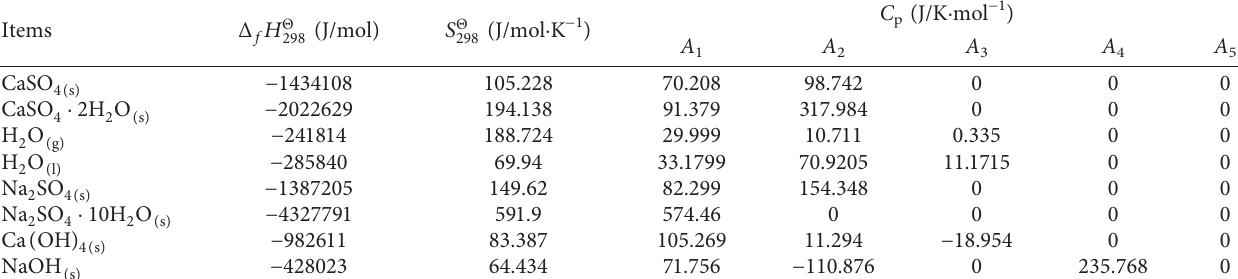
Table 4: Thermodynamic parameters for different products.